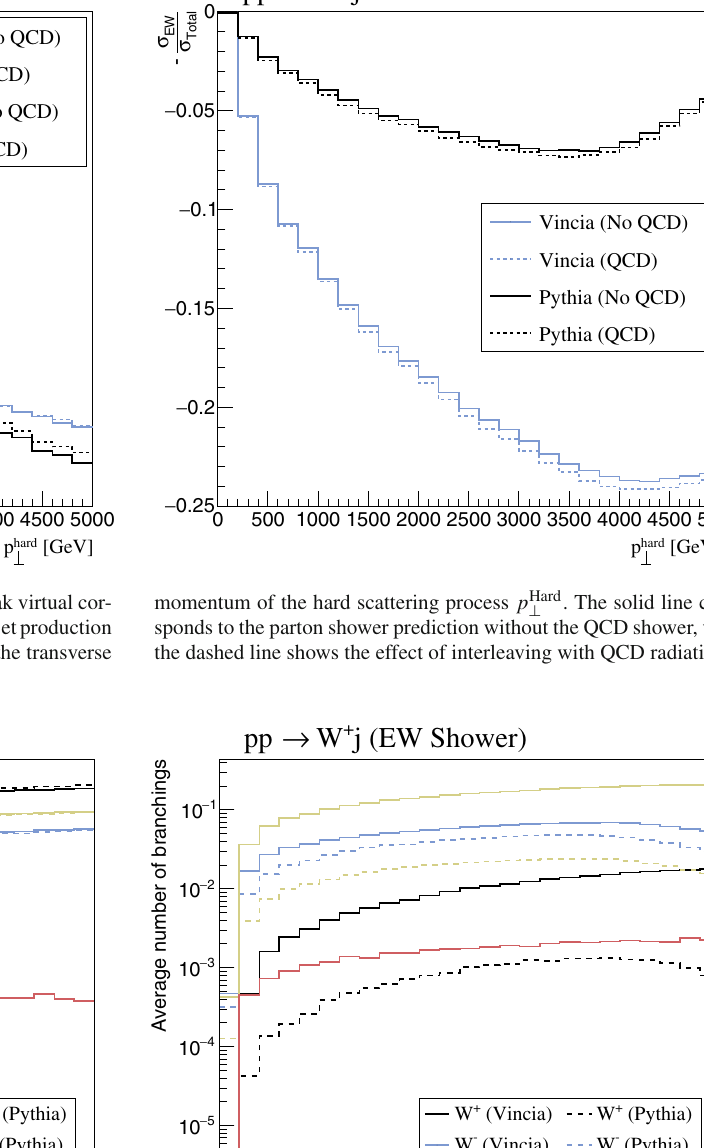
Fig. 7 Averagenumberofweakbosonemissionsinexclusivedijetproductionandexclusive W + +jetproductionatcenter-of-massenergy TeV as a function of the transverse momentum of the hard scattering process p Hard